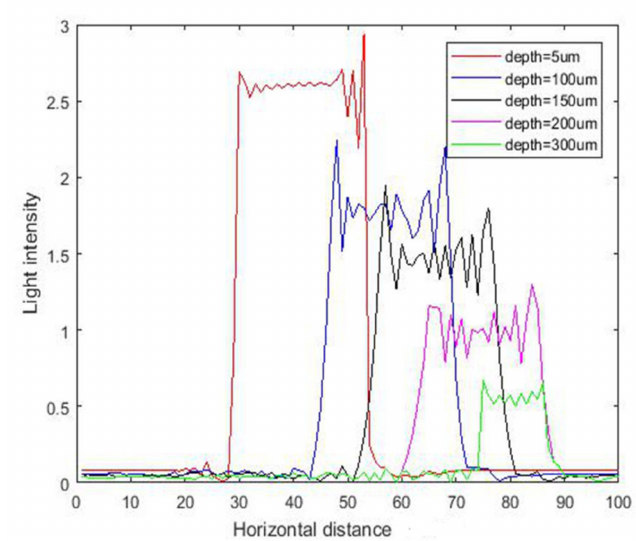
Figure 15. The intensity curve for inclined exposure with di ff erent depths at 23.5 ◦ incident angle.